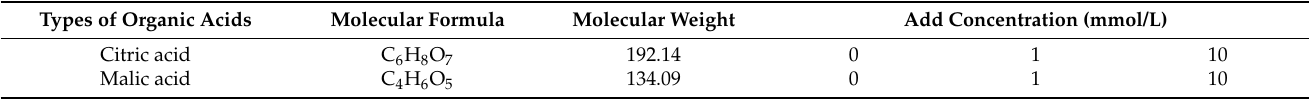
Table 1. Concentration and type of organic acid added to Ni-contaminated reclaimed soil samples.